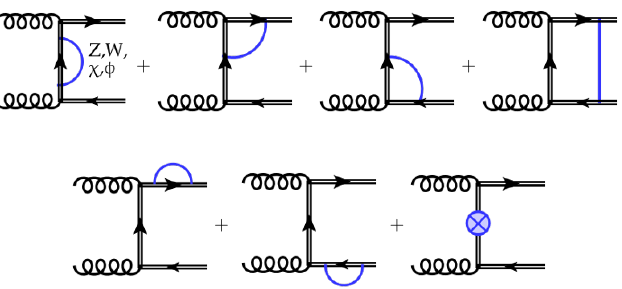
Figure 3 . Loop diagrams and mass counter term receiving EFT contributions in the t -channel gg